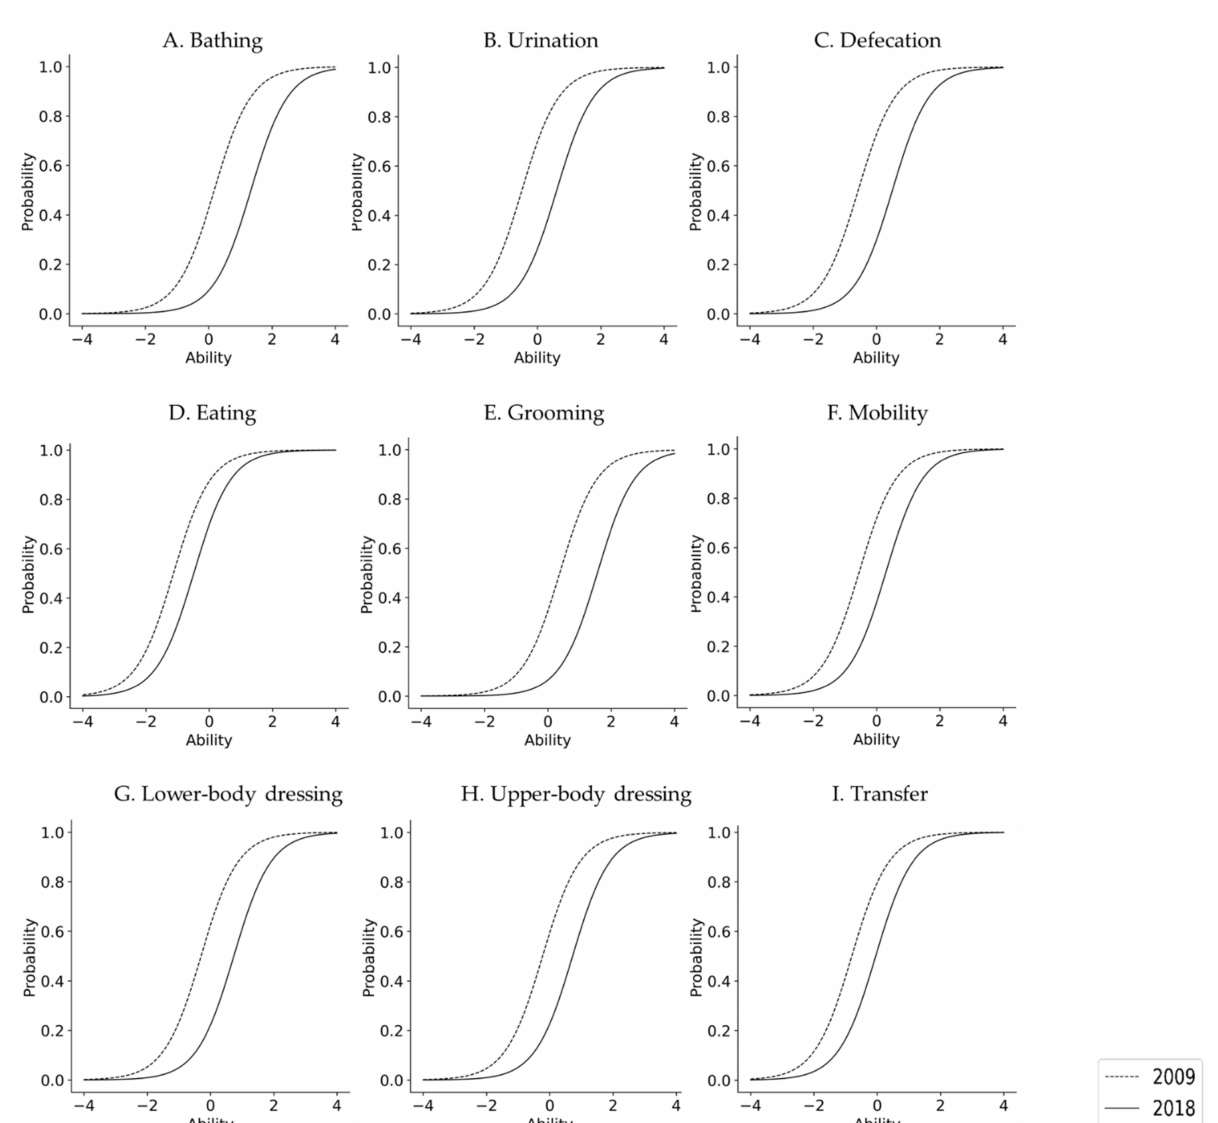
Figure 2. Difficulties in their ADL independence for men from 2009 to 2018. The X-axis denotes each person’s disability level. The Y-axis denotes the probability of independence for each activity. The dotted line represents the 2008 sample, and the solid line represents the 2018 sample. In 2018, the curve of the model shifted to the right, meaning that the difficulty increased for all items when compared to